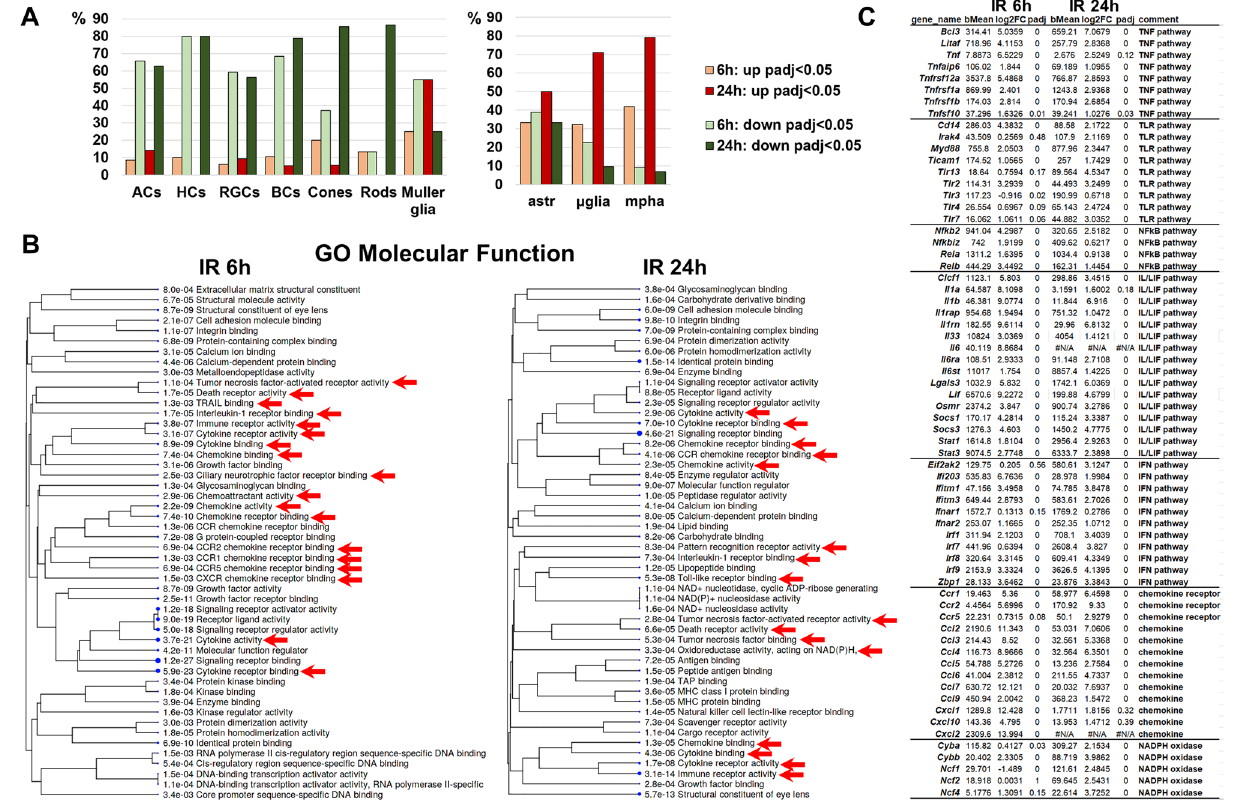
Figure 3. Retinal IR negatively affects the activity of genes necessary for the normal function of neurons, leads to reactive gliosis and enhances the toxic pro-inflammatory response. ( A ) The expression of a significant number of genes that are markers of retinal neurons was downregulated in the IR retina, while the expression of a significant number of glial cell and macrophage markers was increased. The number of genes with increased and decreased expression is presented as a percentage (%) of their total number. ACs—amacrine cells, HCs— horizontal cells, BCs—bipolar cells, astr—astrocyte, µglia—microglia, mpha—macrophages. ( B , C ) The results of the gene ontology (GO) and pathway analysis showed that many genes with increased expression in the IR retina are involved in the neurotoxic pro-inflammatory